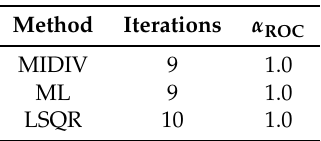
Table 2. Convergence test. ROC, rate of convergence; MIDIV, I-divergence minimization; LSQR, non-linear least